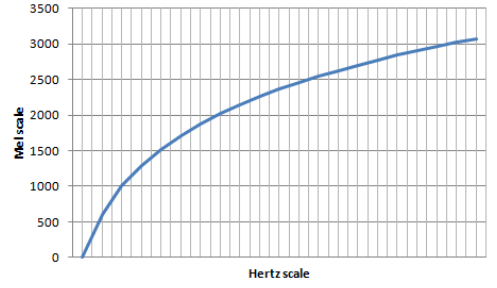
Figure 5. pitch scale vs. mel